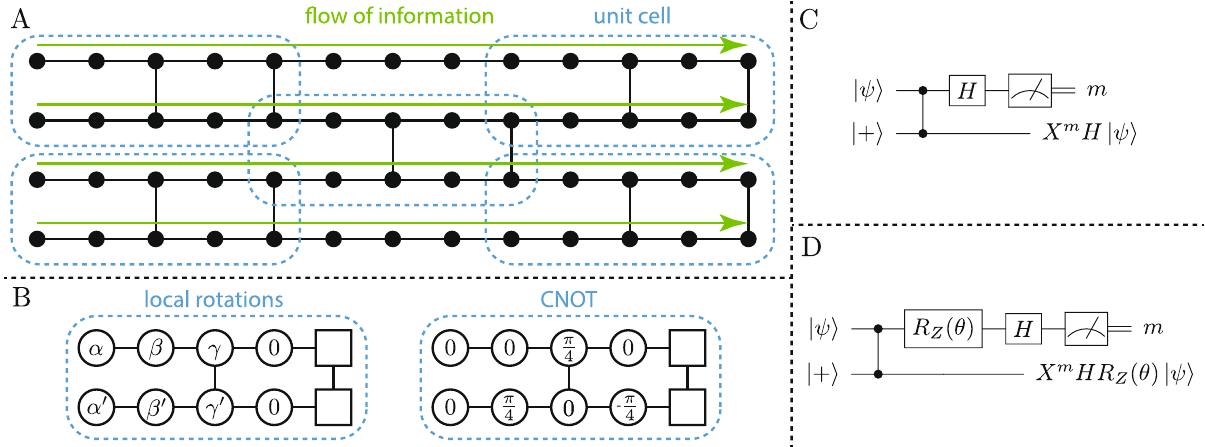
Fig. 4 The structure of measurement-based computation using the brickwork state as the resource. a The brickwork state underlying the UBQC protocol. 10 The same resource state has previously been considered in ref. 30. Logical qubits propagate along horizontal chains of vertices from right to left. These can be thought of as corresponding to wires in a quantum circuit diagram, with each vertex corresponding to the application of a single qubit gate, and vertical edges corresponding to controlled-phase gates between neighbouring qubits. The graph of the resource state is constructed from a regular tiled unit cell. b Possible choices for measurements within the unit cell giving rise to arbitrary single qubit rotations on each logical qubit or to a CNOT gate. c A two qubit teleportation circuit which can be used to understand the propagation of logical qubits along the horizontal chains indicated in A when qubits are measured in the X basis. d A modi fi ed version of the two qubit teleportation protocol which can be used to understand the effect of measurements in arbitrary bases in the XY -plane when propagating logical qubits through the graph, as discussed in ref. 31